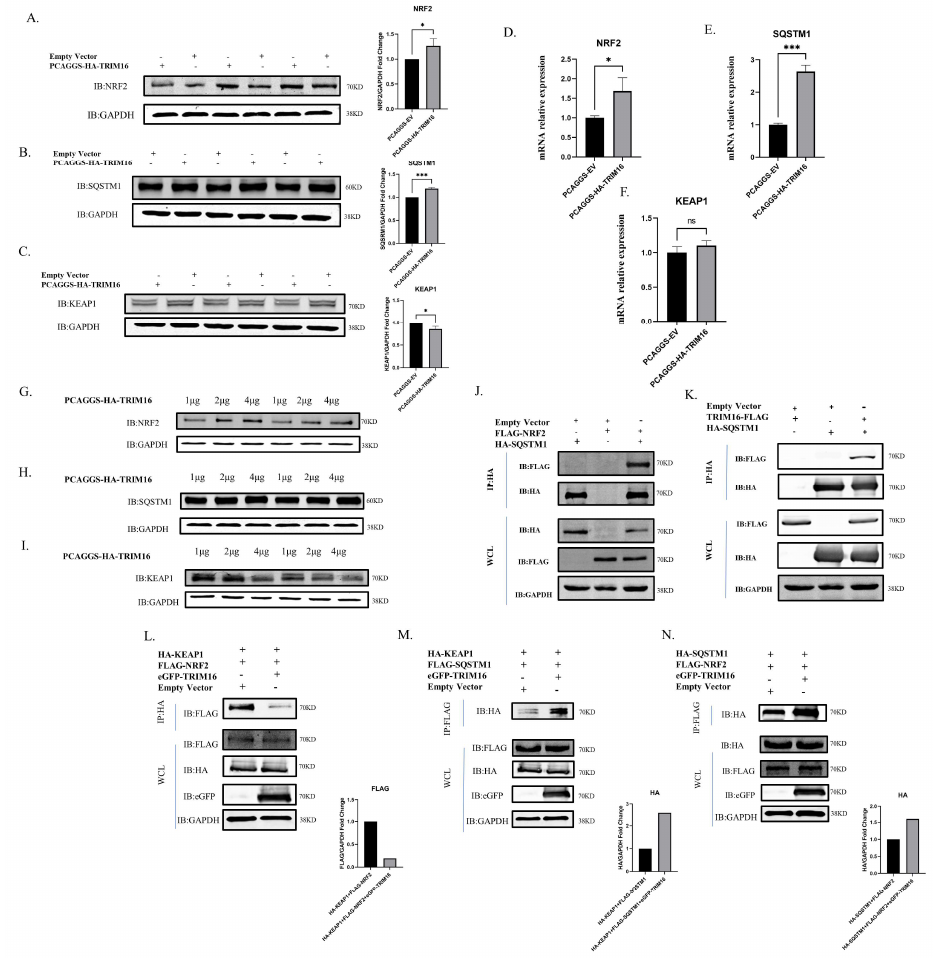
Figure 6. TRIM16 regulates the SQSTM1-KEAP1-NRF2 system. After 24 h of transfection of HA-TRIM16 detected the protein expression of ( A ) NRF2, ( B ) SQSTM1, and ( C ) KEAP1. After 24 h of transfection of HA-TRIM16 detected the mRNA expression of ( D ) NRF2, ( E ) SQSTM1, ( F ) and KEAP1, 1 µg, 2 µg, and 4 µg of TRIM16 were transfected in A549 cells to detect protein expression of ( G ) NRF2, ( H ) SQSTM1, and ( I ) KEAP1.GAPDH was used as a loading control. ( J ) SQSTM1 interacted with NRF2 in transfected cells. HEK 293T cells were transfected with PCAGGS-HA-SQSTM1 and PCAGGS-FLAG-NRF2. After 24 h, the cells were lysed and immunoprecipitated using anti-HA agarose beads. ( K ) TRIM16 interacted with SQSTM1 in transfected cells. HEK 293T cells were transfected with PCAGGS-HA-TRIM16 and PCAGGS-FLAG-SQSTM1. After 24 h, the cells were lysed and immunoprecipitated using anti-HA agarose beads. ( L ) Co-immunoprecipitation analysis of the interaction between NRF2 and KEAP1 in absence and presence of TRIM16. ( M ) Co- immunoprecipitation analysis of the interaction between KEAP1 and SQSTM1 in absence and pres- ence of TRIM16. ( N ) Co-immunoprecipitation analysis of the interaction between NRF2 and SQSTM1 in absence and presence of TRIM16. All data were expressed as means ± SD, the Student’s t -test was used to analyze the differences. ( ns p > 0.05, * p < 0.05 and *** p < 0.001). 3.7. TRIM16 Affects Ubiquitination Status of NRF2 To investigate whether NRF2 was modified by TRIM16 ubiquitination in the normal state of the cell, the ubiquitination modification of NRF2 by the TRIM16 protein was de- tected using CoIP. HA-UB, FLAG-NRF2, and eGFP-TRIM16 were co-transfected into HEK293T cells. The results of CoIP showed that TRIM16 modified NRF2 via ubiquitina- tion of the E3 ubiquitin ligase function (Figure 7A). To explore how TRIM16 affects NRF2 ubiquitination, an immunoprecipitation analysis was performed in the presence of two different ubiquitin protein variants, one ubiquitinated only at lysine at position 48 (HA-